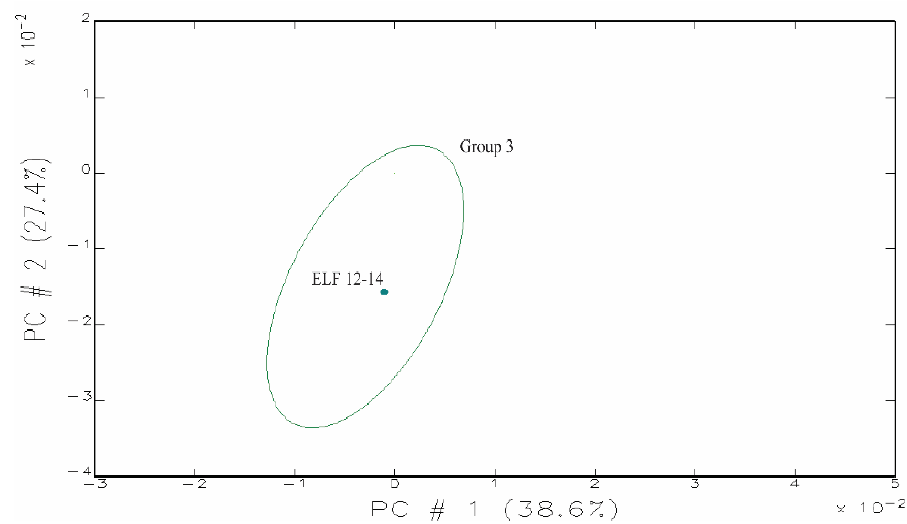
Figure 18. Scatterplot comparing PC 1 and PC 2 from the Saronic Gulf Core Group 3 [95] assemblage demonstrating the location of ELF 12/14 within Group 3. Image by William Gilstrap.